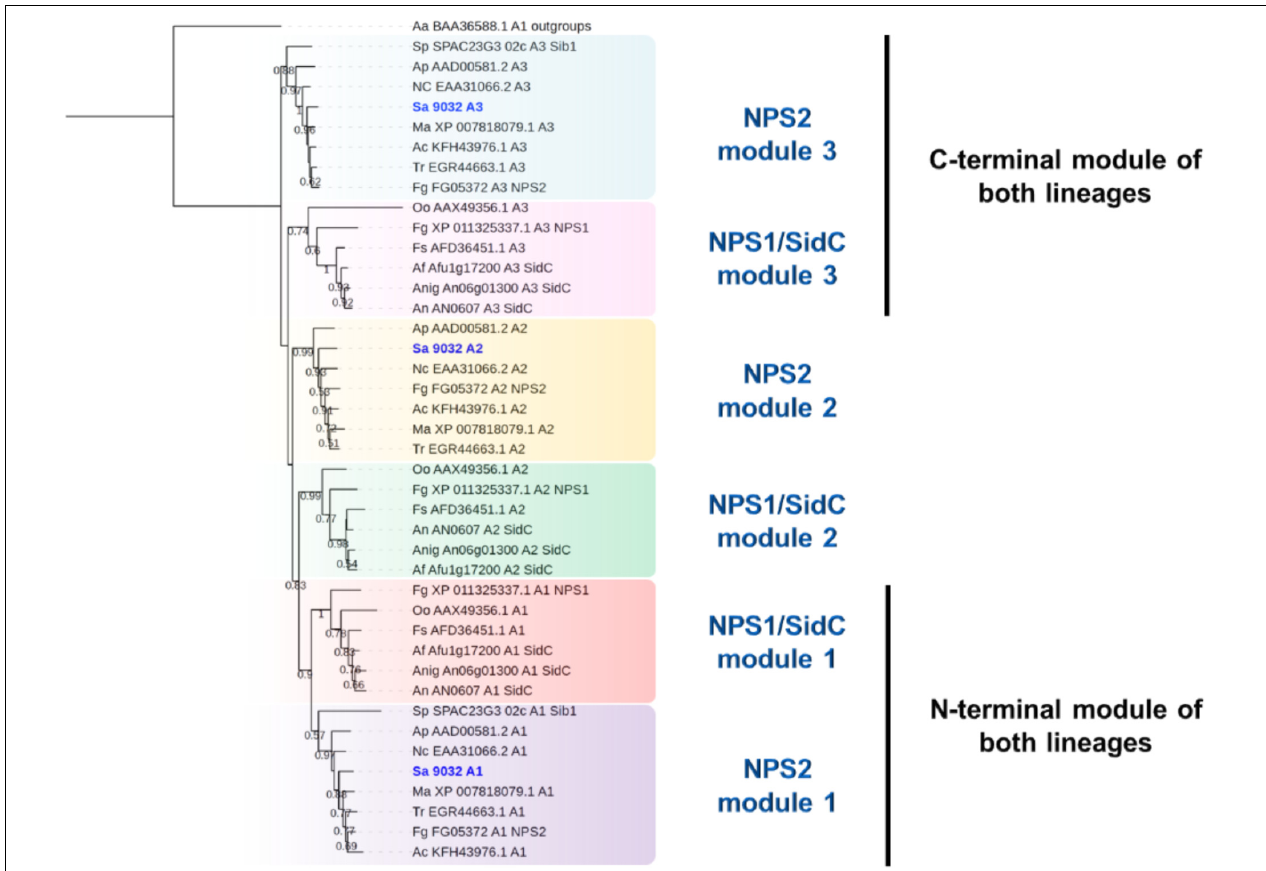
FIGURE 5 | Maximum likelihood phylogenetic tree (PhyML + LG model) of intracellular siderophore-producing NRPS generated from an extended A-domain dataset. N-terminal A-domains of both lineages group together while the C-terminal A-domains are more phylogenetically distant. Bootstrap support values greater than 50% are reported below branches. All S. apiospermum NRPS A-domains are shown in bold